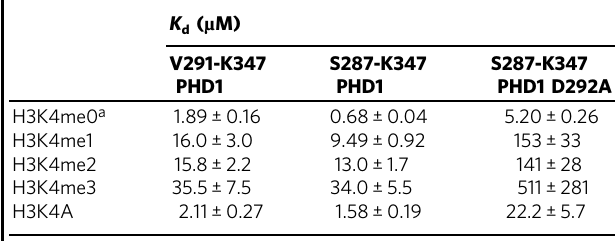
Table 1 Binding af fi nities of differently modi fi ed H3